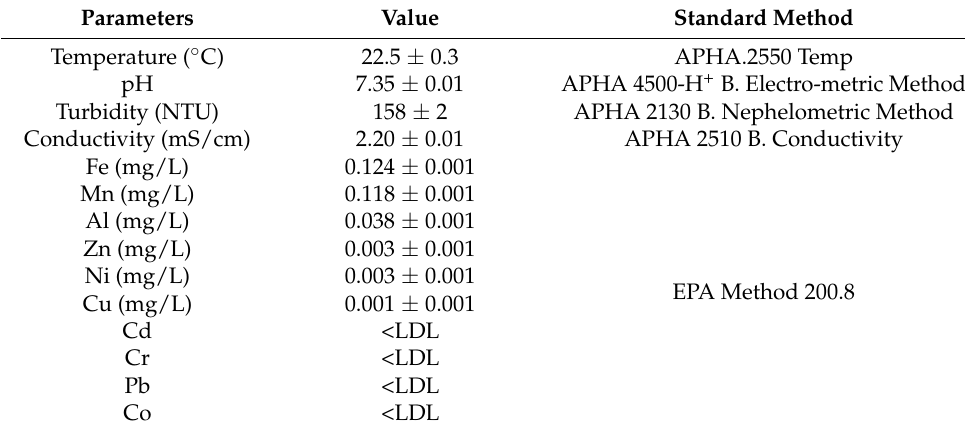
Table 2. Characteristics of primary treated municipal wastewater.